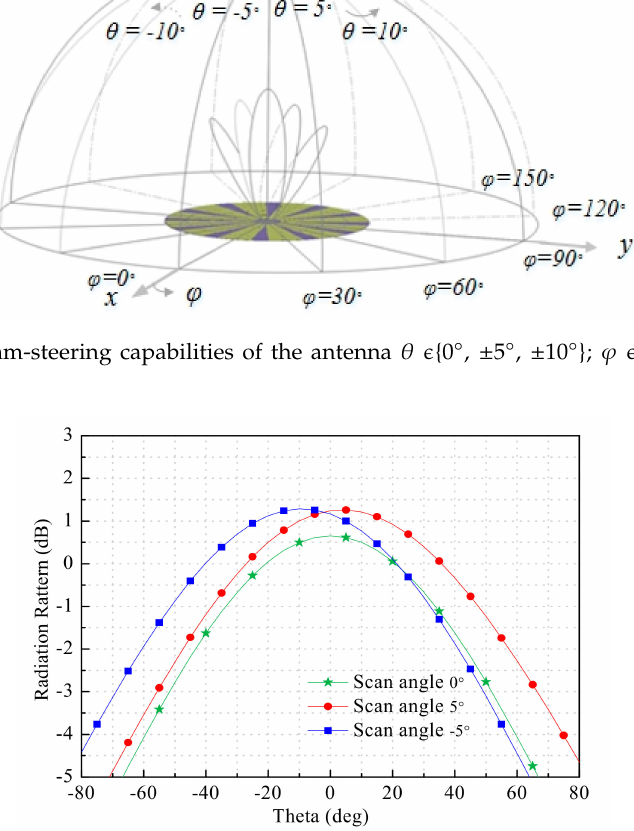
Figure 6. Simulated radiation patterns ( ϕ = 30 ◦ plane) θ = 0 ◦ ( m = 0) and θ = ± 5 ◦ ( m = 3) at 0.5